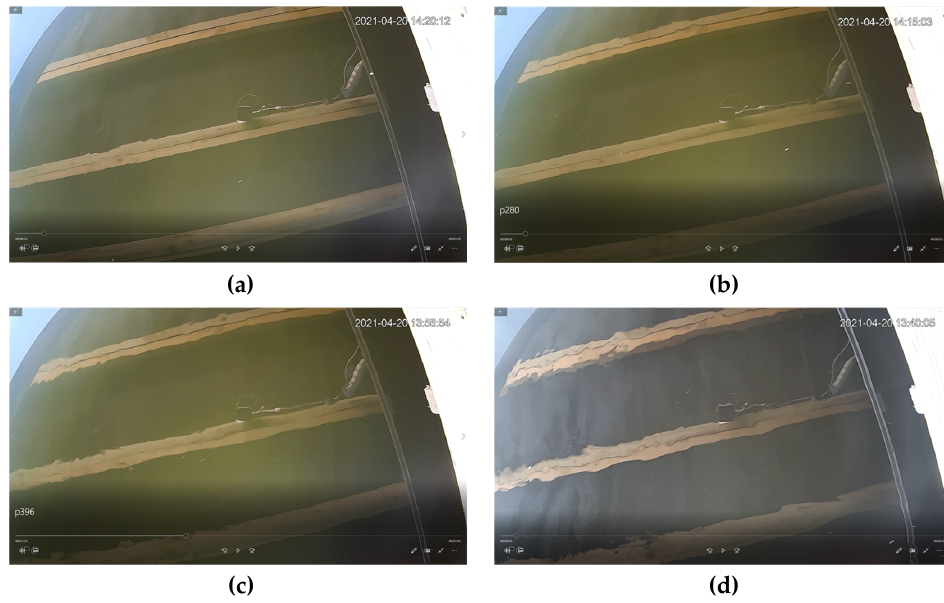
Figure 2. Sample video frames acquired for various measured water-flow velocities: ( a ) 1.86 dm 3 /s;